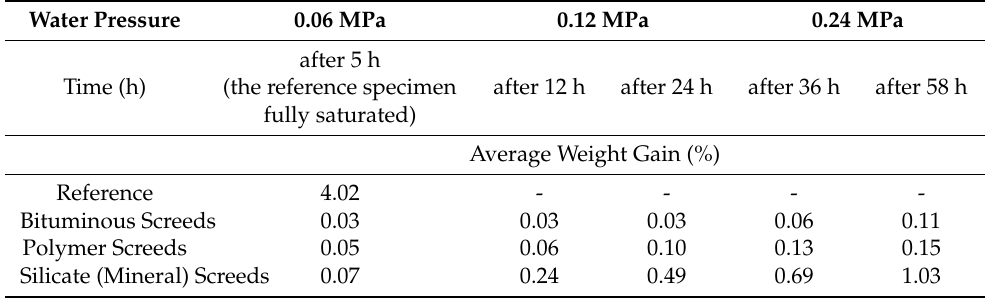
Table 2. Average weight gain.